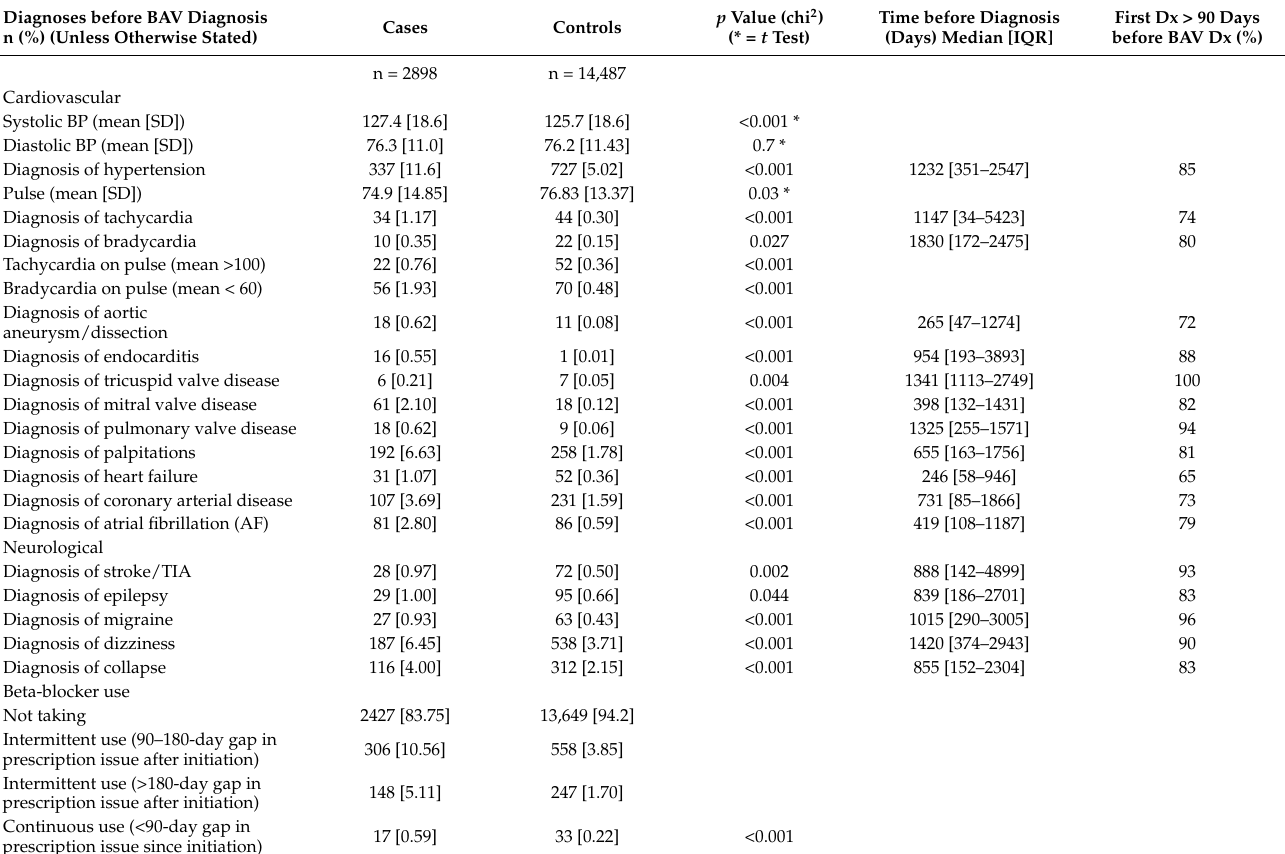
Table 4. List of associated features and time before